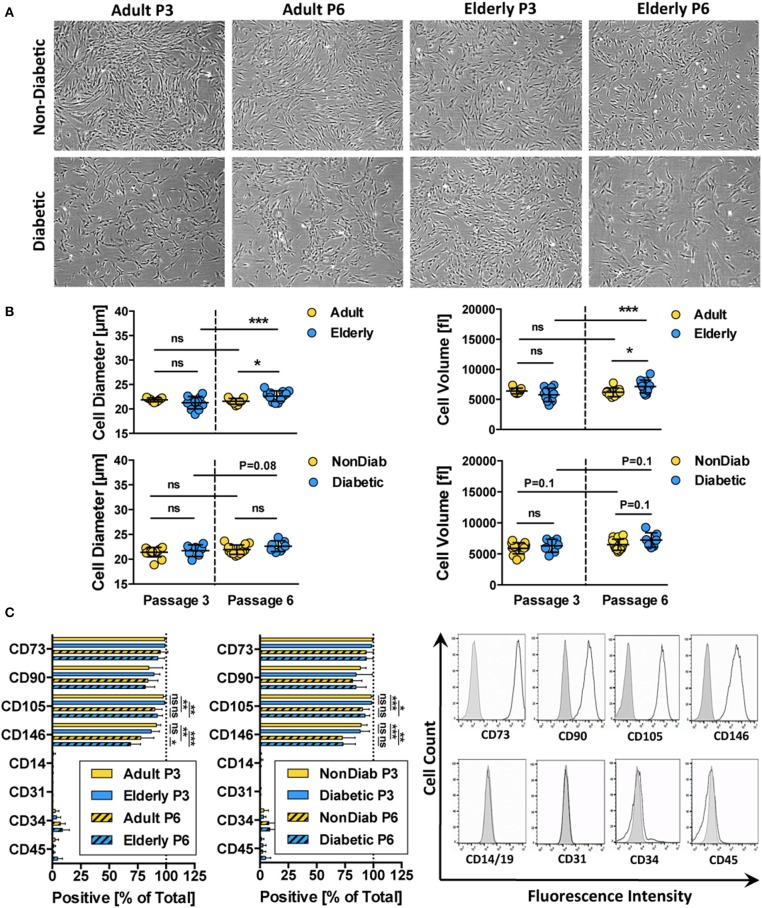
Morphology and immunophenotype of BMSCs. (A) Representative bright-field microscopy images of BMSC cultures at passage 3 and 6, comparing adult vs. elderly and non-diabetic vs. diabetic donors, showing typical fibroblast-like morphology with a trend toward more irregular morphology in diabetic donors; (B) analysis of cell size and cell volume of trypsin-detached BMSCs from adult vs. elderly (n = 9 vs. 12) and non-diabetic vs. diabetic donors (n = 14 vs. 7). Adult and elderly have similar cell size and volume at passage 3, and the cell size of adult donor-derived BMSCs does not increase with passages, while elderly donor-derived BMSCs display cell enlargement with increasing passage; and (C) flow cytometry analysis of BMSCs (% positive cells; n = 6 random adult or elderly donors at early passage 1–3) with representative histograms shown to the right (unlabeled controls are shown in solid gray). The cells highly express typical BMSC-associated markers CD44, CD73, CD90, and CD105 while exhibiting no/weak expression of non-MSC-associated markers CD14, CD31, CD34, and CD45. Data are shown as mean ± SD, and statistical evaluation was performed by Student's t-test (*p < 0.05 and ***p < 0.001).